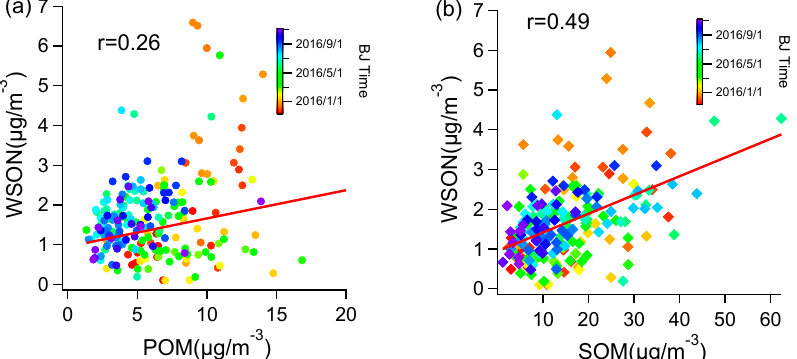
Figure 9. Scatter plots of WSON versus POM ( a ), and WSON versus SOM ( b ) (colored by time).